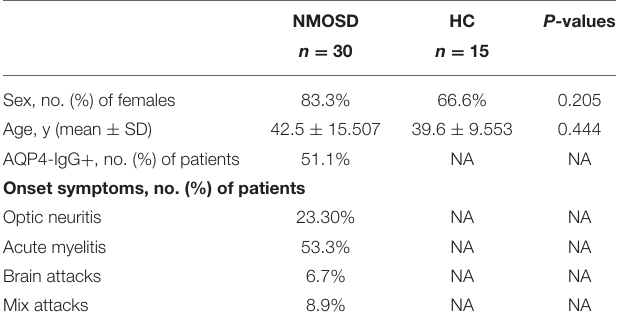
TABLE 3 | Demographics and clinical characteristics of participants for IRAK1 mRNA.